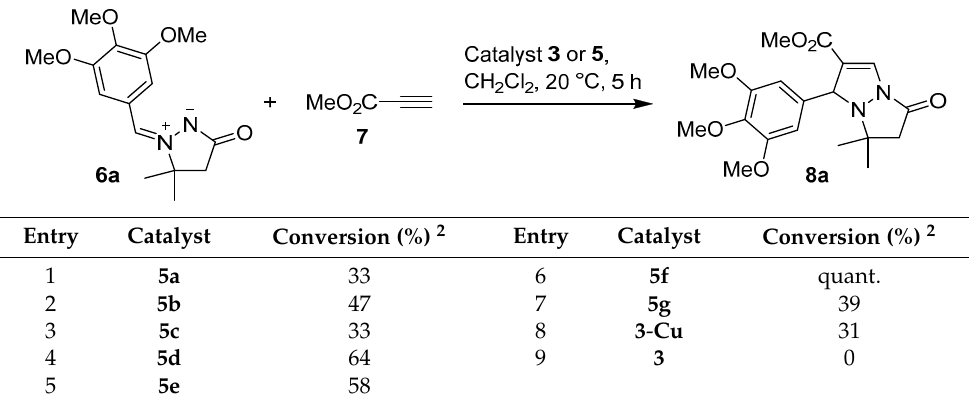
Molecules 2021 , 26 , x FOR PEER REVIEW Table 1. Evaluation of catalytic activity of 5 a–g , 3 - Cu , and 3 in model cycloaddition reaction 1 . Table 1. Evaluation of catalytic activity of 5 a – g , 3 - Cu , and 3 in model cycloaddition reaction 1 . Table 1. Evaluation of catalytic activity of 5 a–g , 3 - Cu , and 3 in model cycloaddition reaction 1 .